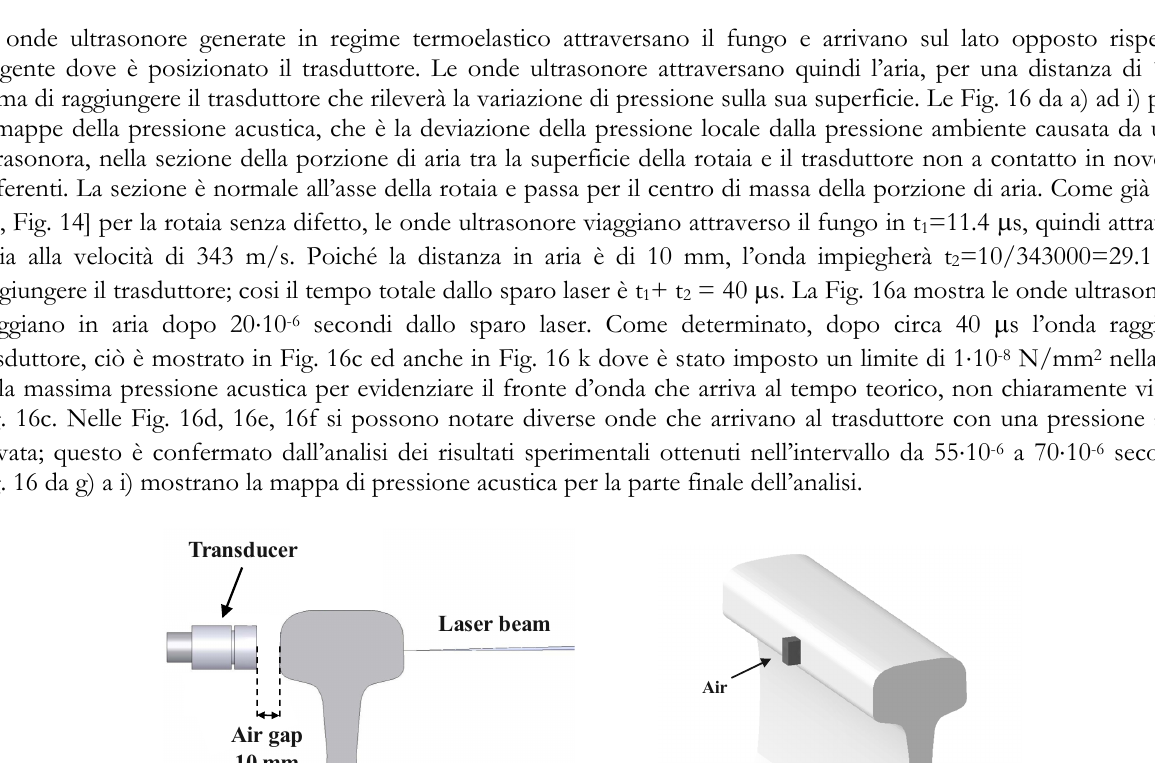
Figura 14: Foto del setup sperimentale per lo studio del fungo.